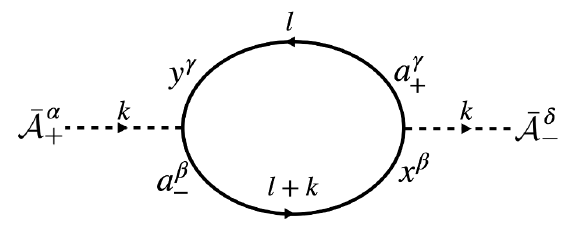
Figure 2 . The only divergent diagram contributing to the 1-loop effective action (2.20) for theories with Lax connection of the form